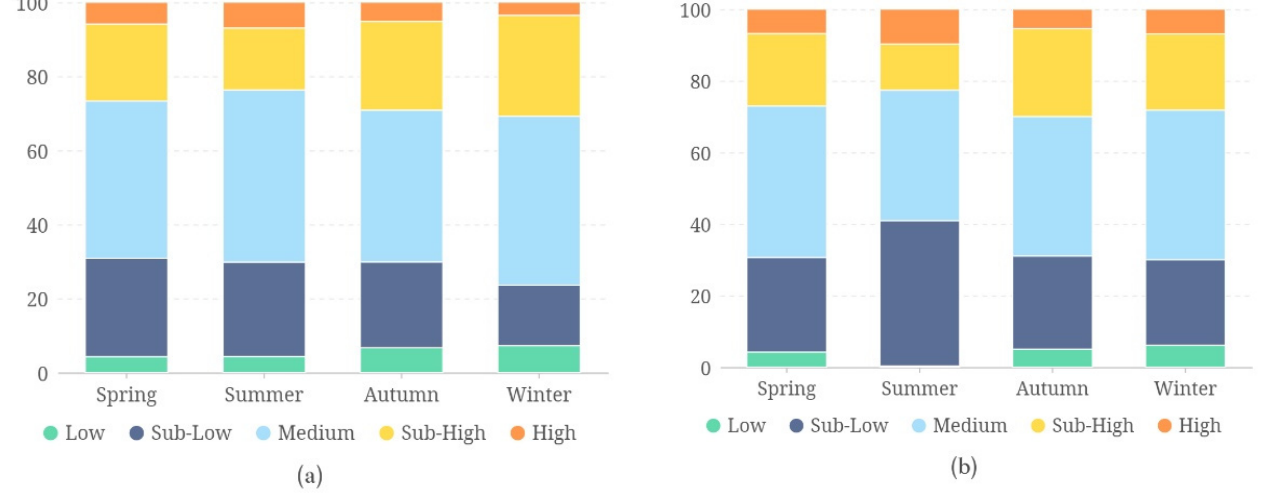
Figure 2. Stacked bar chart of the temperature zones at different levels in the study area in different seasons. ( a ) 2010, ( b ) 2020.